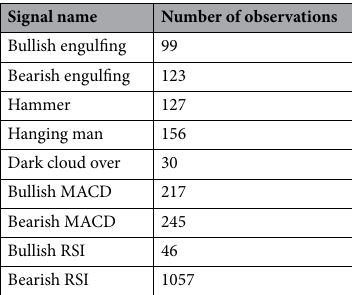
Table 1. Summary of the number of observations of technical analysis signals in pooled 17,140 weekly candlesticks of COVID-19 data for 237 countries from January, 3, 2020 to July, 29, 2021 data obtained from WHO 19 .